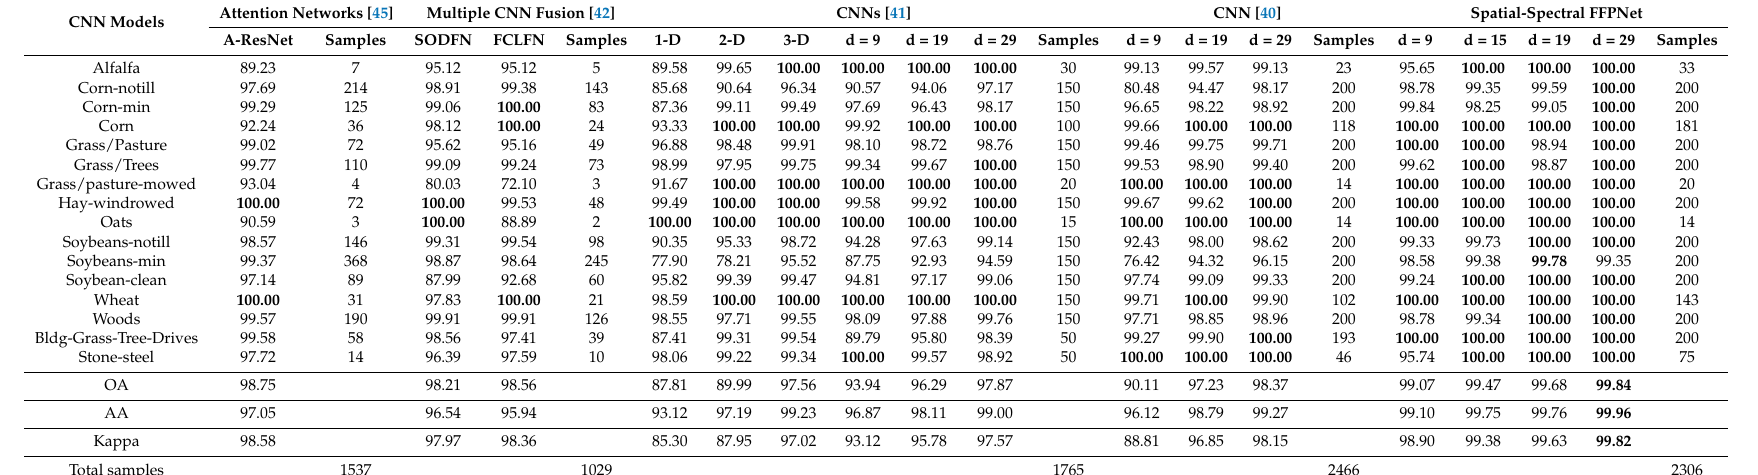
Table 17. Classification accuracies (in %) of different CNN models developed from 2016 to 2019 and the proposed model for the IP dataset (with maximum epoch = 200 and mini-batch size = 24). The values in bold are the best. The CNN by [40] is considered as the baseline.